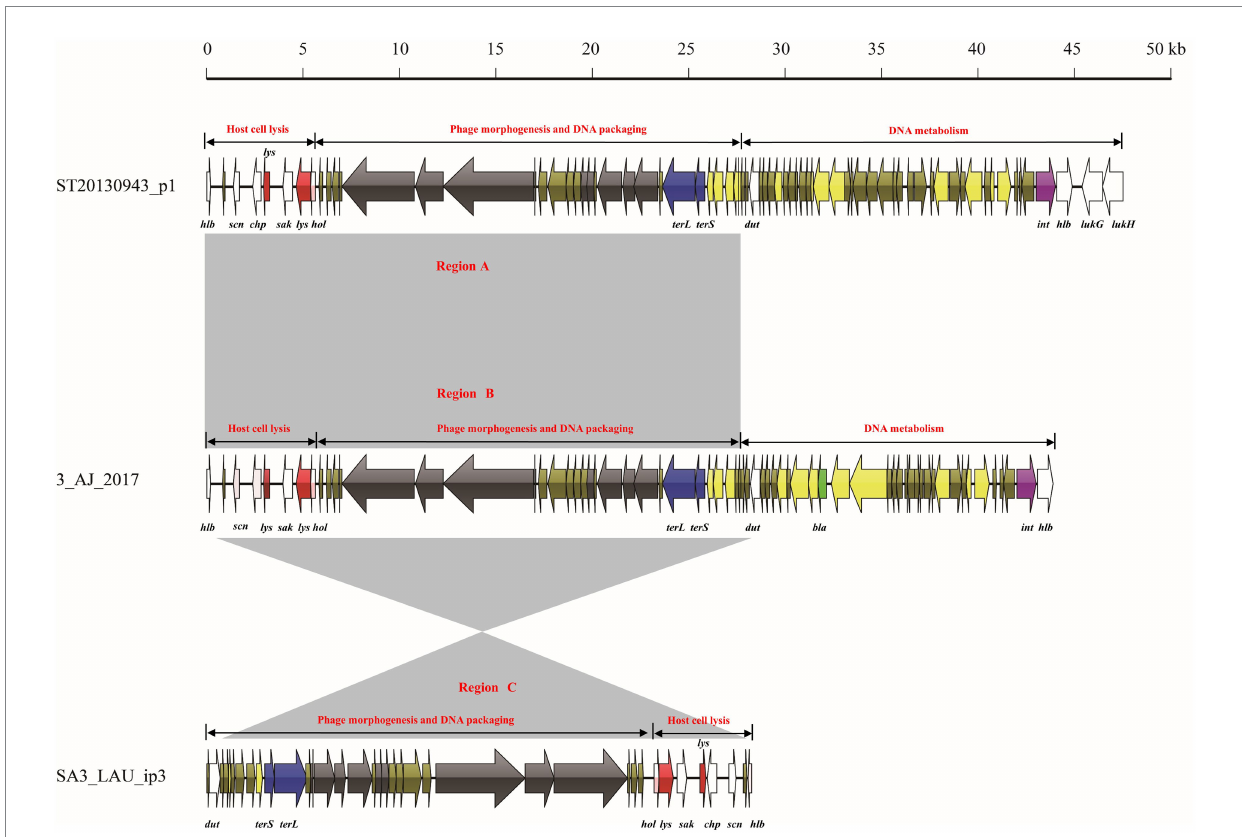
FIGURE 4 Comparative structural analyses of lytic phage-23MRA with intact prophage UTSW_MRSA_55_p3 and incomplete prophage